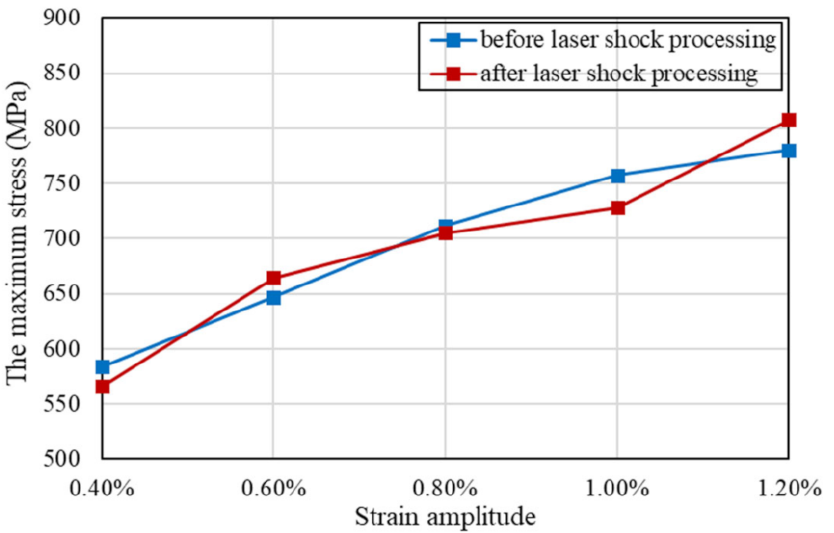
Figure 4. Cyclic strain response to a cycle of controlled deformation for ( a ) Inconel 625 without LSP and ( b ) Inconel 625 with LSP at different strain amplitudes with a constant strain rate of 0.4%/s.